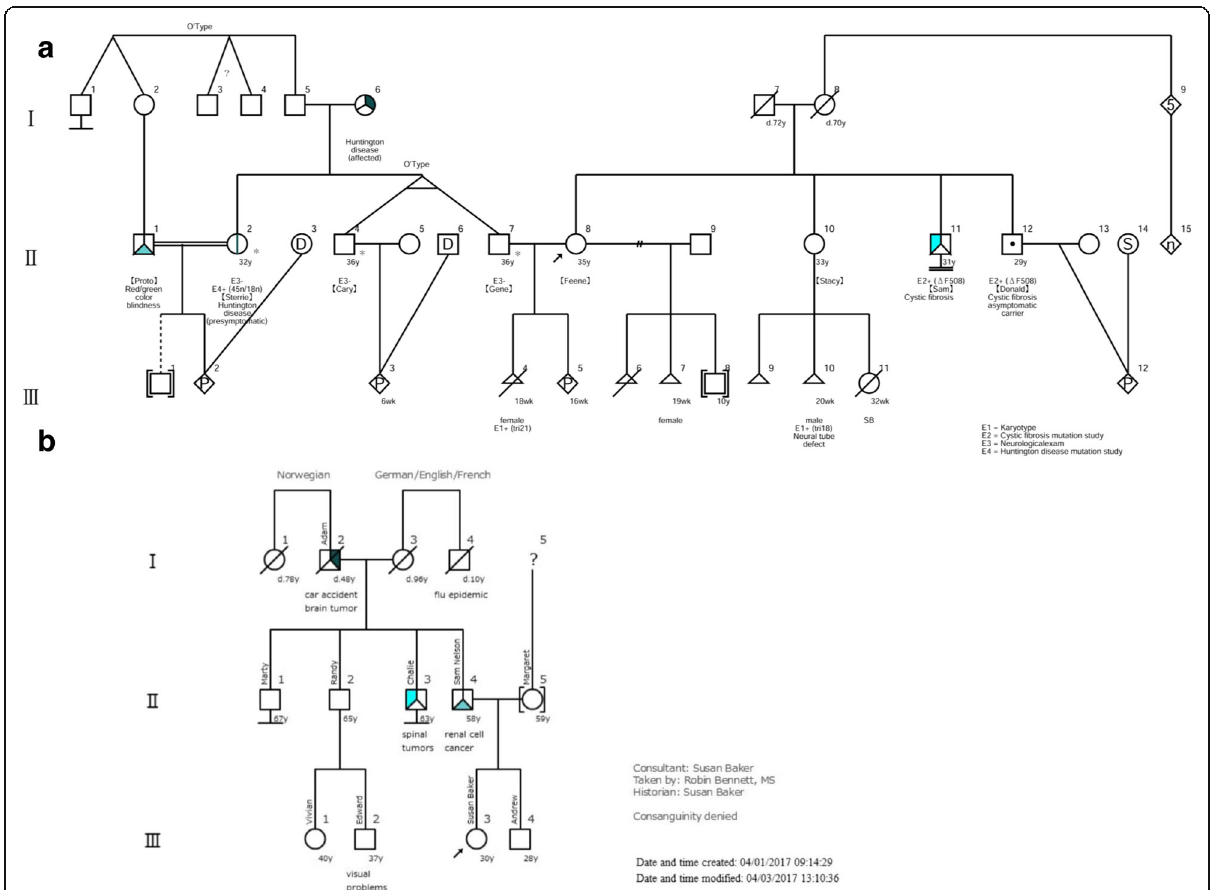
Fig. 2 Fictitious pedigrees created by f-treeGC. a Fictitious ultimate pedigree, b A hypothetical pedigree representative of a family with von Hippel-Lindau syndrome shown in Fig. 1, partially modified from Bennett et al. [1, 7]. The clients are included in the 2nd generation ( a ) or in the 3rd generation ( b ) upon confirmation at system startup